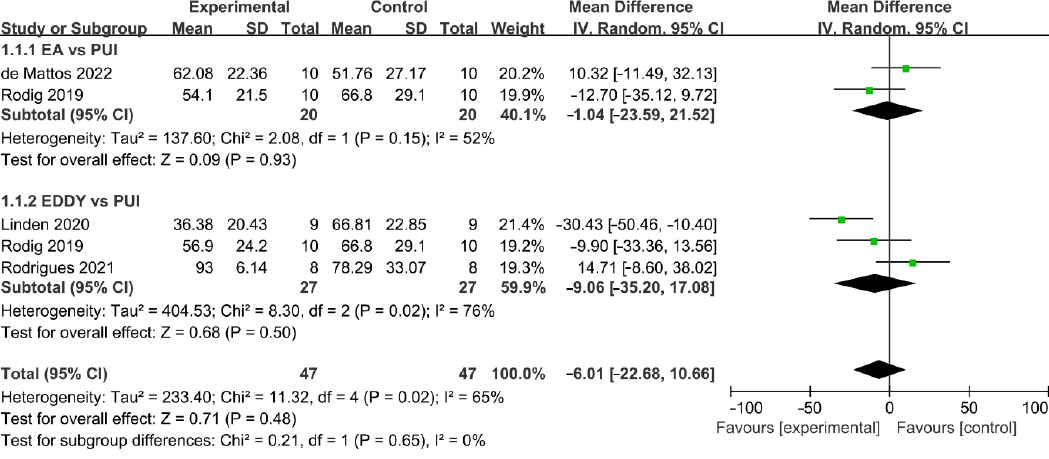
Figure 6. Forest plot and meta ‐ analysis of comparison between SAI and PUI [35,36,39,43].